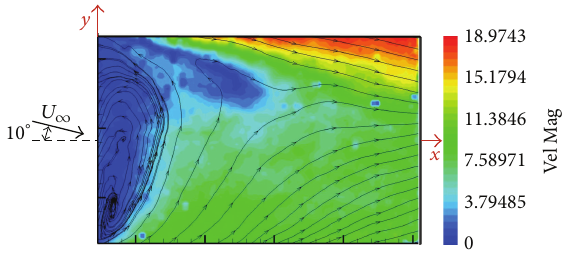
Figure 8: Velocity map in the horizontal plane of the SFS flight deck at 10 ∘ of angle of incidence ( 𝑧/𝐻 = 0.5 ).